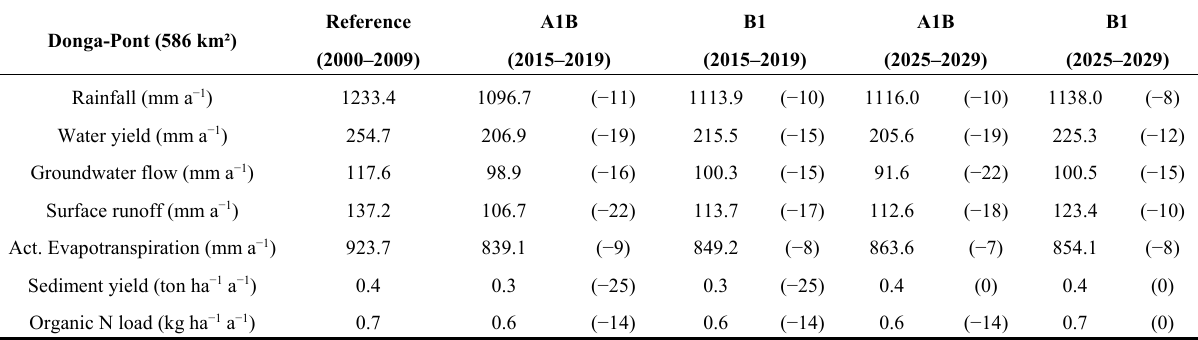
Table 8. Simulated SWAT components under climate scenarios (with unchanged land use map derived from 2003 Landsat image). Deviation (in %) from the reference scenario (2000–2009) are shown in